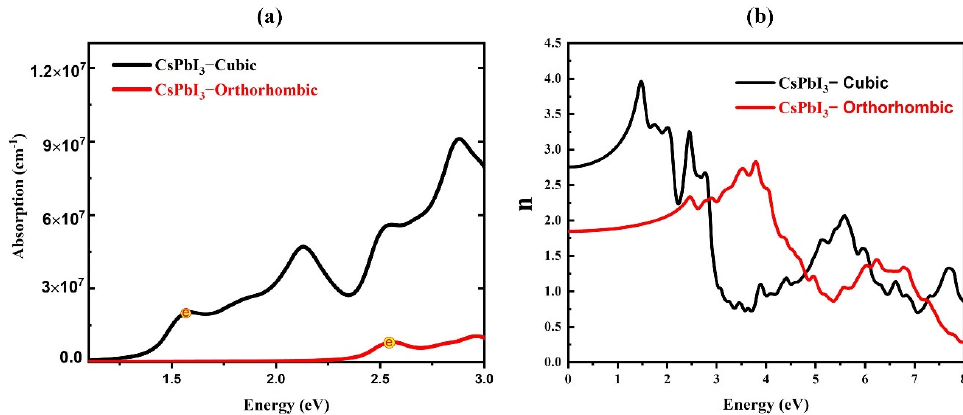
Table 6. Wavelength of absorption edge and refraction index of CsPbI 3 structure for the cubic and orthorhombic phases.